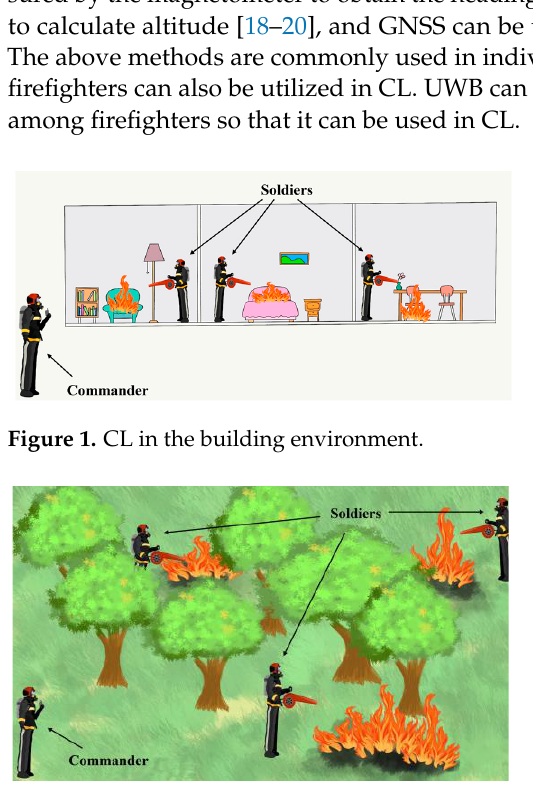
Figure 2. CL in the forest environment.